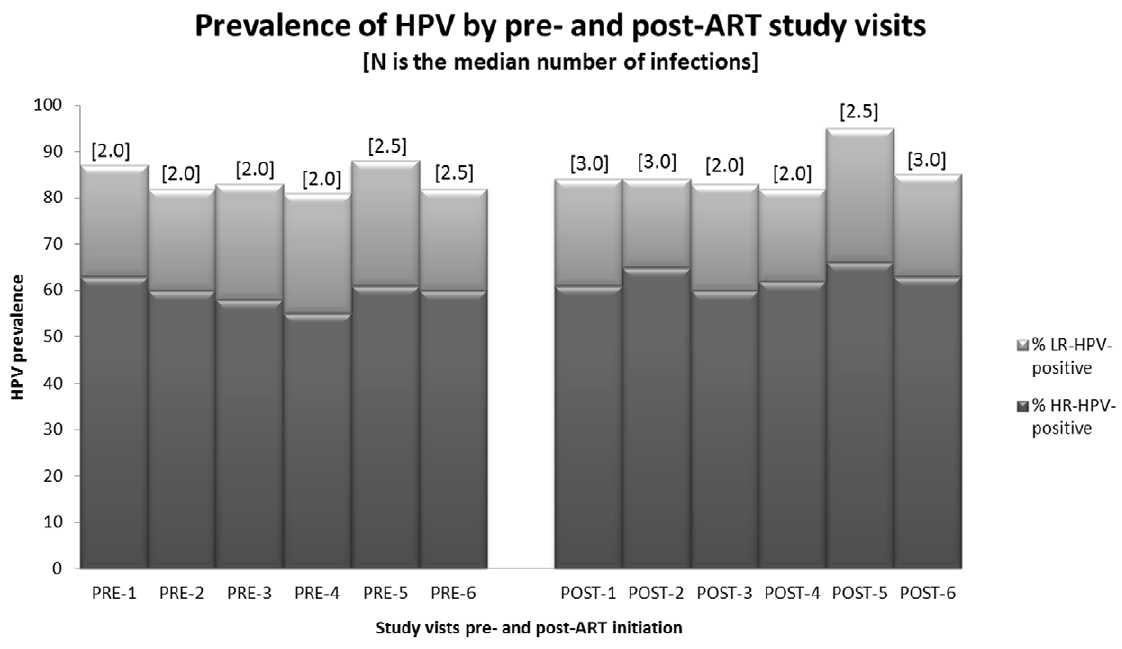
Figure 1. Pattern of high- and low-risk monthly HPV detection and median number of HPV [ in brackets ] types during the pre- and post-ART initiation periods. Abbreviations: infection with only low-risk human papillomavirus types (LR-HPV); high-risk human papillomavirus types alone or with LR-HPV types (HR-HPV).